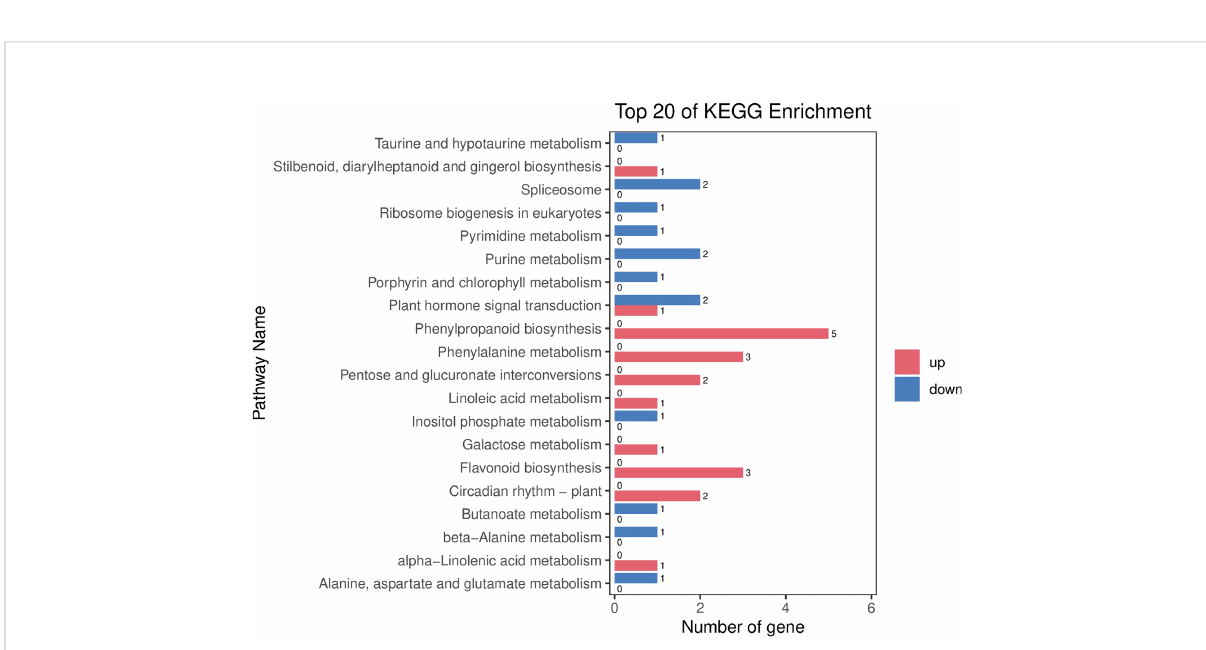
FIGURE 6 The differentially expressed genes or proteins are grouped hierarchically stretched GO terms, biological process, cellular components, and molecular functions.